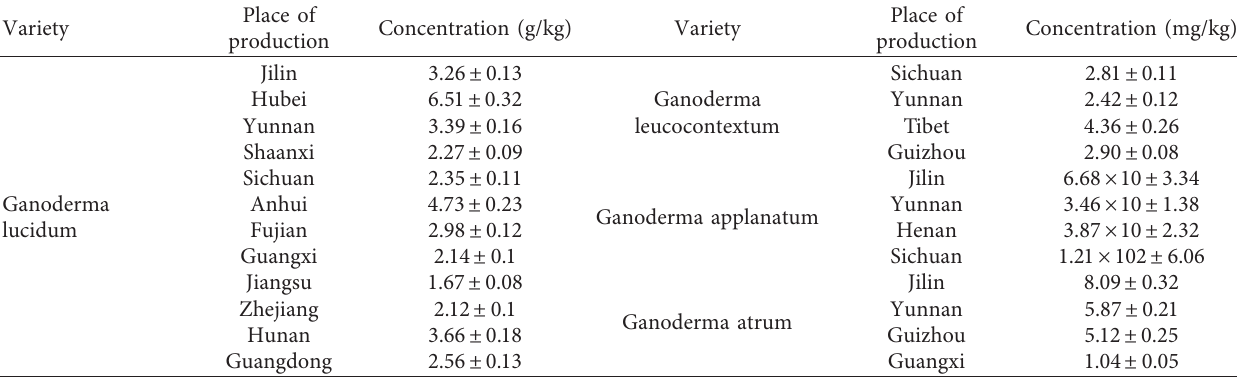
Table 5: Determination results of ganoderic acid A content in G . lucidum from different varieties and sources. Variety